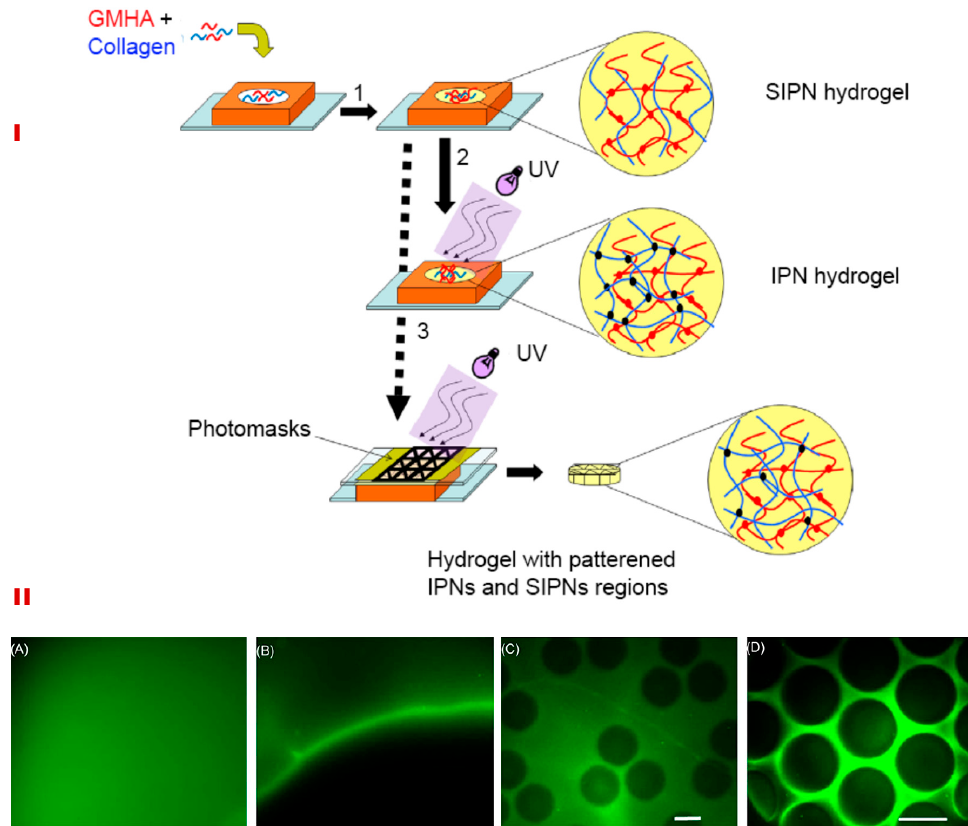
Figure 5. Schematic for synthesizing IPNs, SIPNs, and photopatterned hydrogels ( I ). HA and collagen solution were suspended in the silicone mold and collagen was permitted to undergo fibrillogenesis at 37 ◦ C (1). This resulted in the formation of a SIPN, which was then exposed to ultra-violet light to yield a full IPN (2). Alternatively, photo patterning was performed using a photomask, which resulted in SIPN and IPN patterns within a single hydrogel (3) ( I ). The lower panel ( II ) shows the macro- and micro-patterned hydrogels formed due to differential crosslinking densities. A macropatterned hydrogel is shown in which half was exposed to UV before ( A ) and after washing the un-crosslinked fluorescein acrylate ( B ). In addition, ( B ) shows the interface between the macropatterned halves. Micropatterning within a single bulk hydrogel of a 500 μ m thickness is shown in C and D . (Scale bar- 150 μ m). Reproduced and modified with permission from Elsevier (2009) [151].